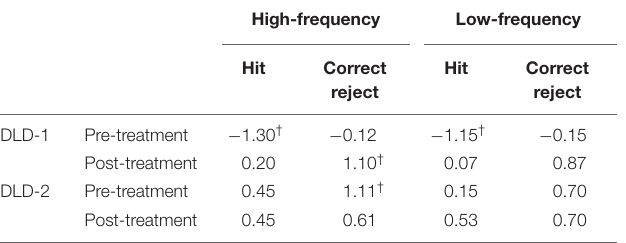
TABLE 1 | Z-scores for hits and correct rejects pre- and post-training for DLD-1 and